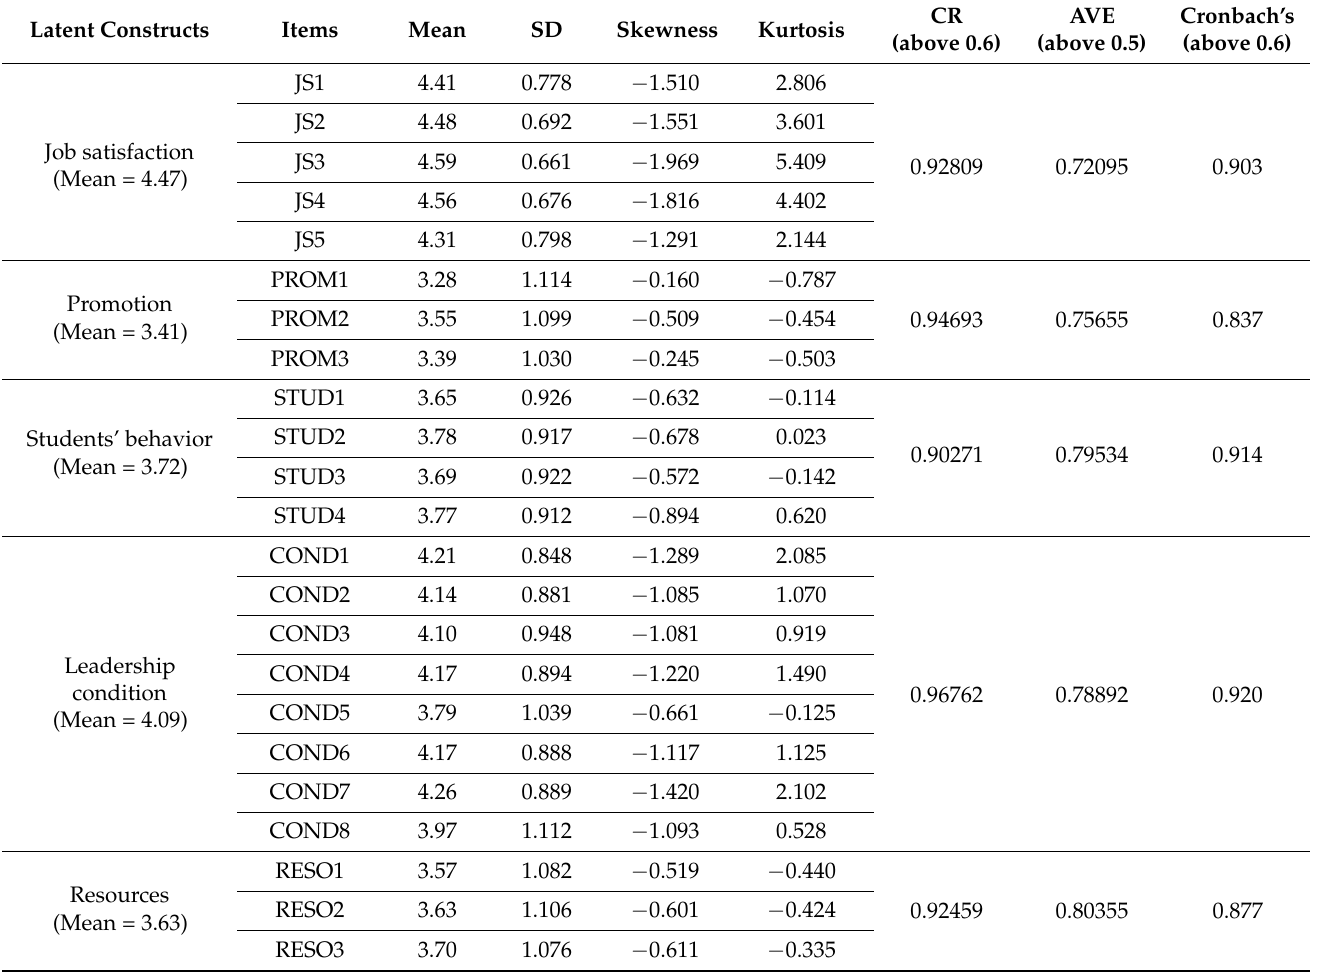
Table 2. Reliability